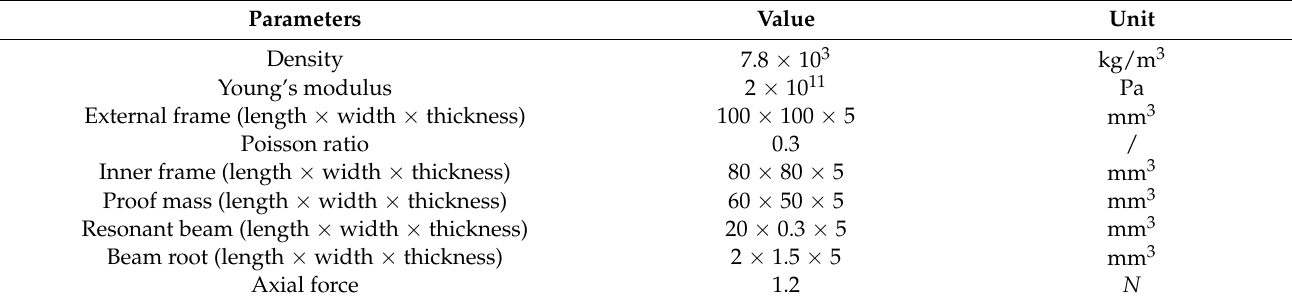
Table 3. Parameters of the resonant